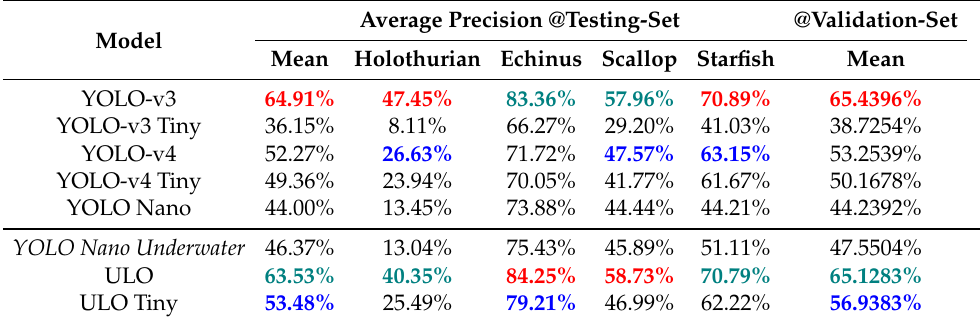
Table 2. Performance of the object detectors evaluated by average precision. The top three results are marked in red , green , and blue ,